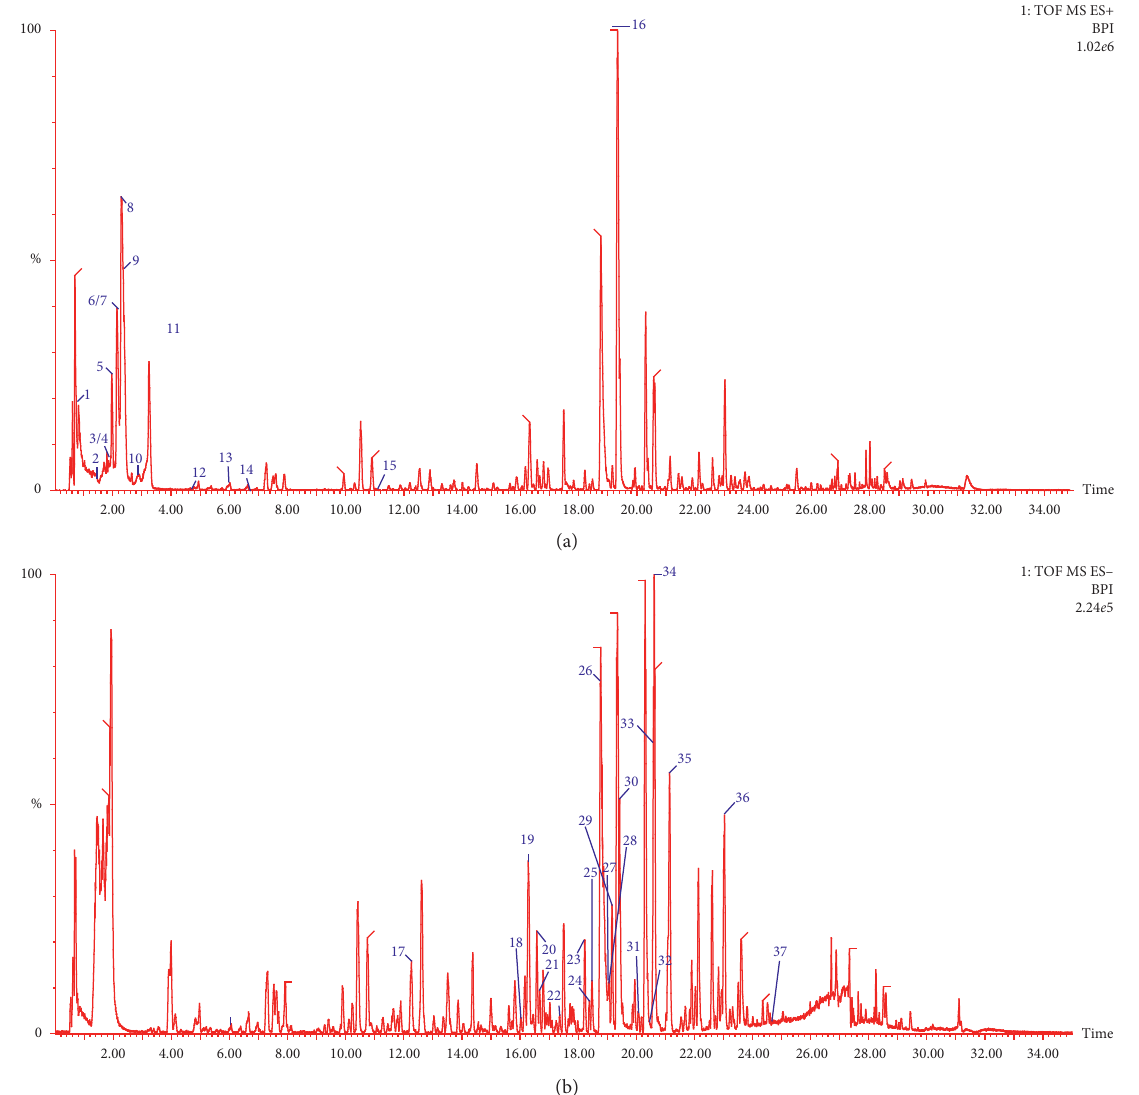
Figure 2: The base peak ion (BPI) flow diagram of Sophora flavescens in the (a) positive and (b) negative